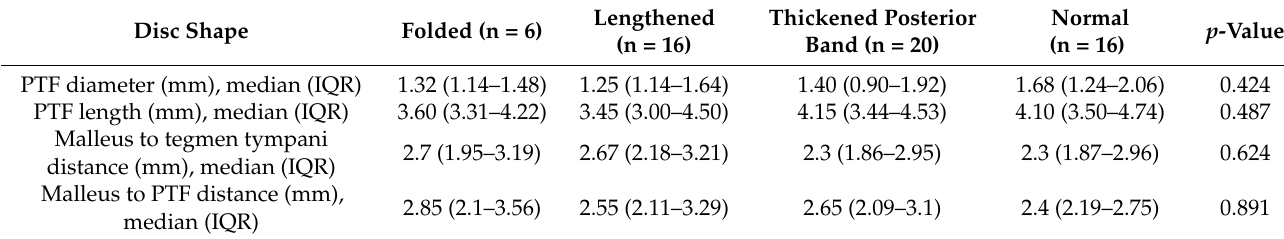
Table 4. PTF dimensions and malleus position related to disc shape.